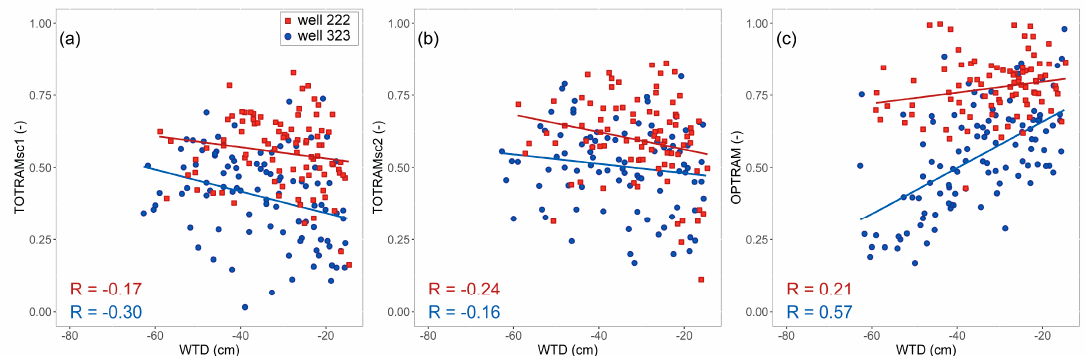
Figure 9. Soil moisture index from ( a ) TOTRAM Scenario 1, ( b ) TOTRAM Scenario 2, and ( c ) OPTRAM as a function of water table depth (WTD) measured in wells 225 (treed) and 323 (treeless). TOTRAMs and OPTRAM values are presented as an average of four pixels the closest to the wells.